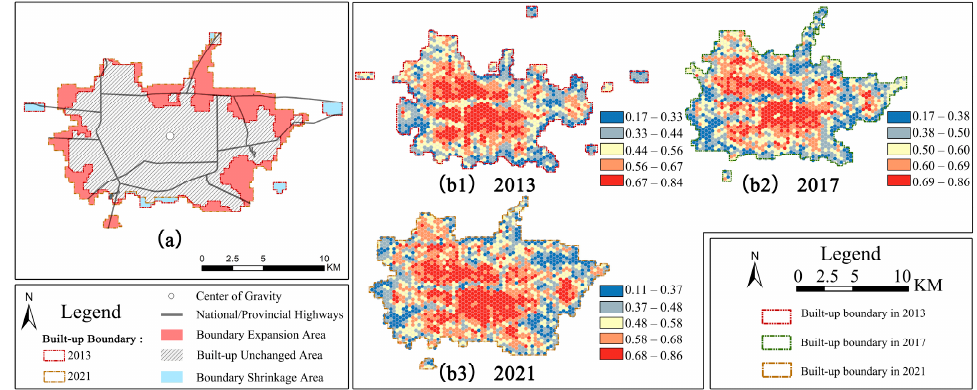
Figure 3. ( a ) Diagram of the built-up zone growth–decline area; (( b1 )–( b3 )) LUQ in 2013/2017/2021.